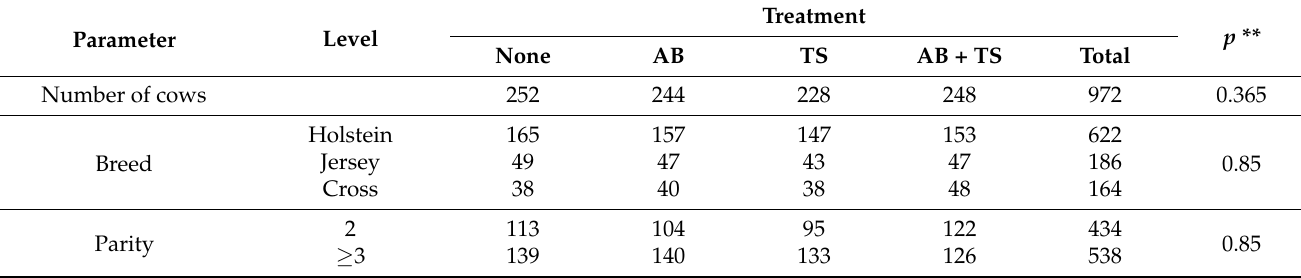
Table 1. Comparison of the categorical baseline traits for dairy cows ( n = 972 cows) from eight herds block randomized to one of four treatments at dry-off (AB, TS, AB + TS, None) *. Treatment Parameter Level